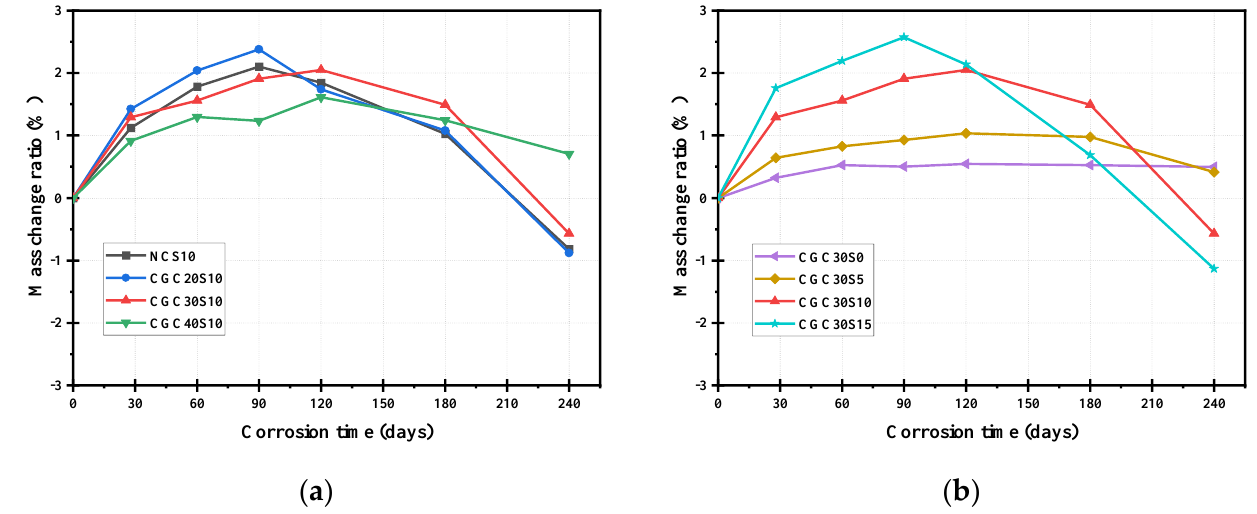
Figure 4. Mass change ratio of specimens at different corrosion times under sulfate attack: ( a ) different concrete; ( b ) different sulfate concentration.